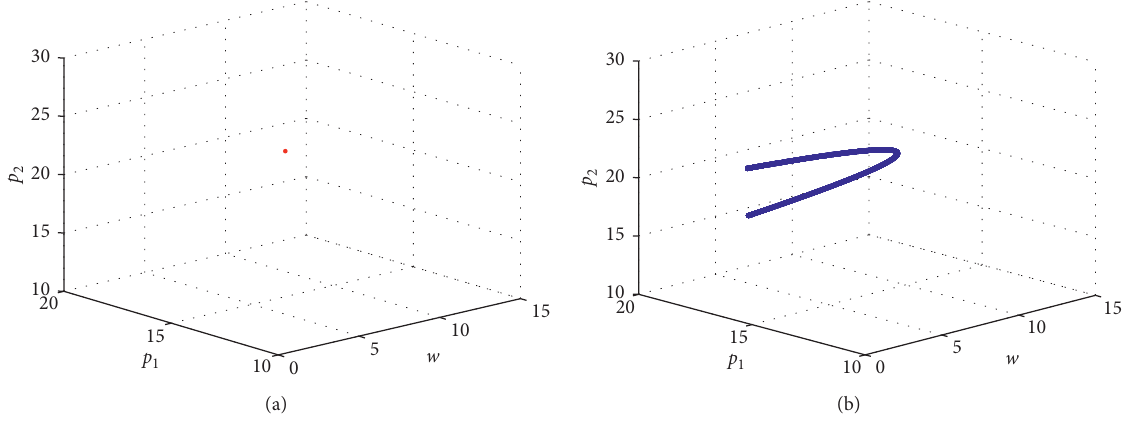
Figure 5: Chaos attractor of the dynamic system (9) with respect to α